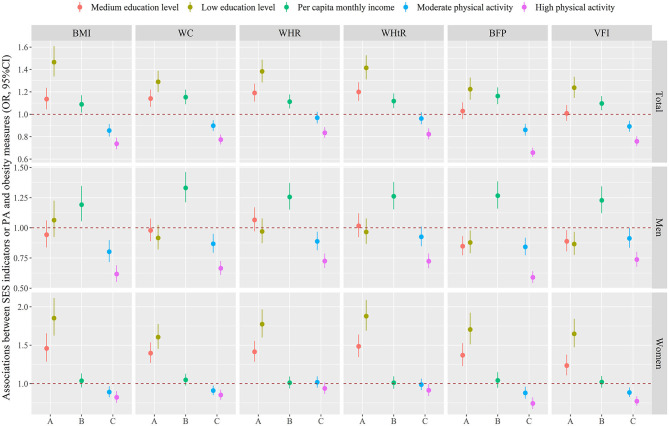
Associations between education level (A) or per capita monthly income (B) or PA (C) and obesity measures. Logistic regression analyses were performed using a fully adjusted model that adjusted for region, age, marital status, smoking status, drinking status, fruit and vegetable intake, high fat diet, SES indicators or PA. The dots and lines were exhibited the estimated regression coefficient and corresponding 95% confidence intervals, respectively. SES, socioeconomic status; PA, physical activity; BMI, body mass index; WC, waist circumference; WHR, waist-to-hip ratio; WHtR, waist-to-height ratio; BFP, body fat percentage; VFI, visceral fat index.